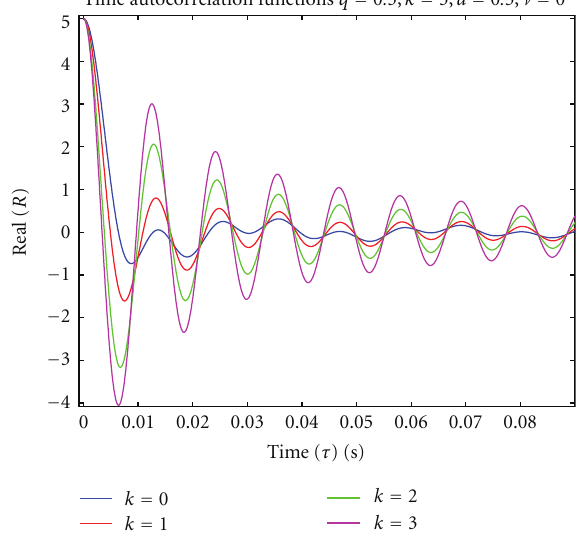
Figure 7: Time autocorrelation function of real part of envelope.